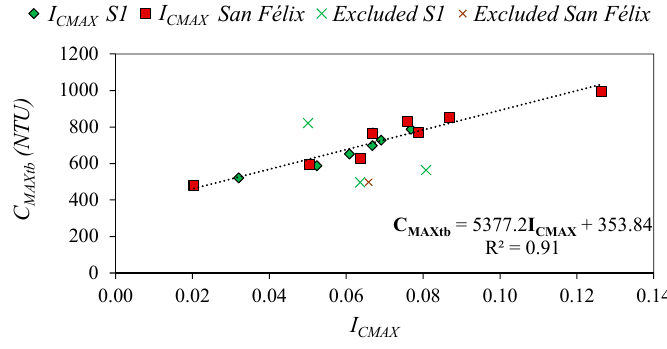
Figure 7. Linear adjustment of C MAXtb with the prediction index I CMAX .